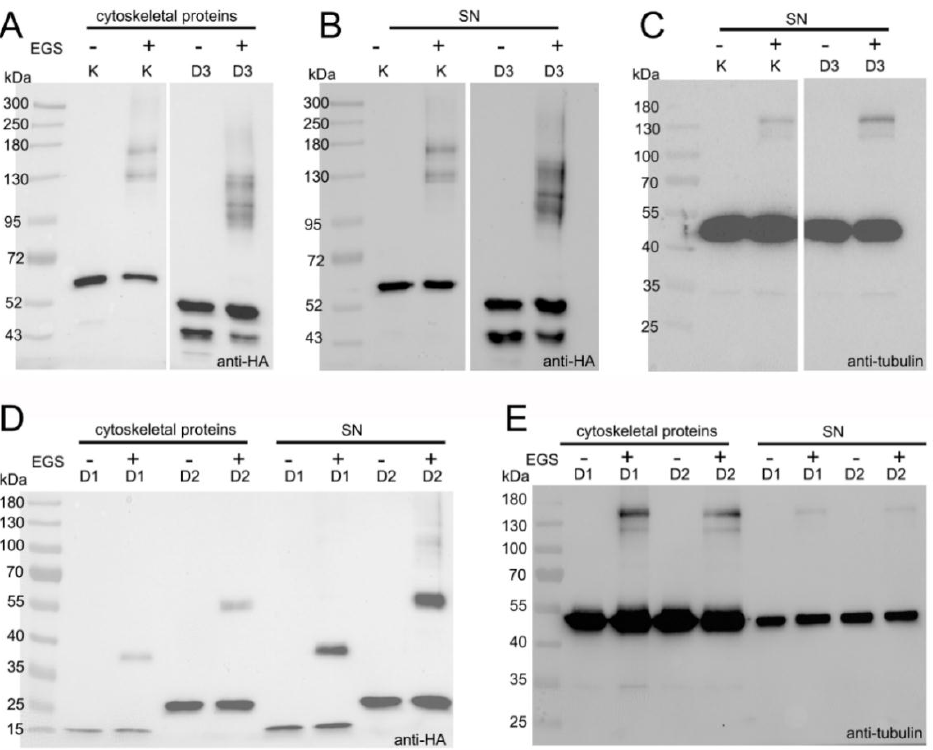
Figure 6. LisH domain mediates the formation of Kat2-HA complexes. ( A – E ) A Western blot-based identification of the HA-positive complexes ( A , B , D ) formed either in the cytoskeletal or supernatant (SN) fractions isolated from Tetrahymena cells overexpressing Kat2-HA (K), Kat2-HA M1-T139 (D1), Kat2-HA M1-L194 (D2), or Kat2-HA M101-V539 (D3) for 4 h. For in vivo crosslinking, overexpressing cells were resuspended in Dryl’s solution supplemented with 0.8 mM ethylene glycol bis(succinimidyl succinate) (EGS) (EGS+) and cultured for 75 min. at 30 °C. Control cells (EGS−) were incubated in Dryl’s medium supplemented with a corresponding concentration of DMSO (0.8%). ( B , C ) Whole blots are presented in Figure S9A–C.